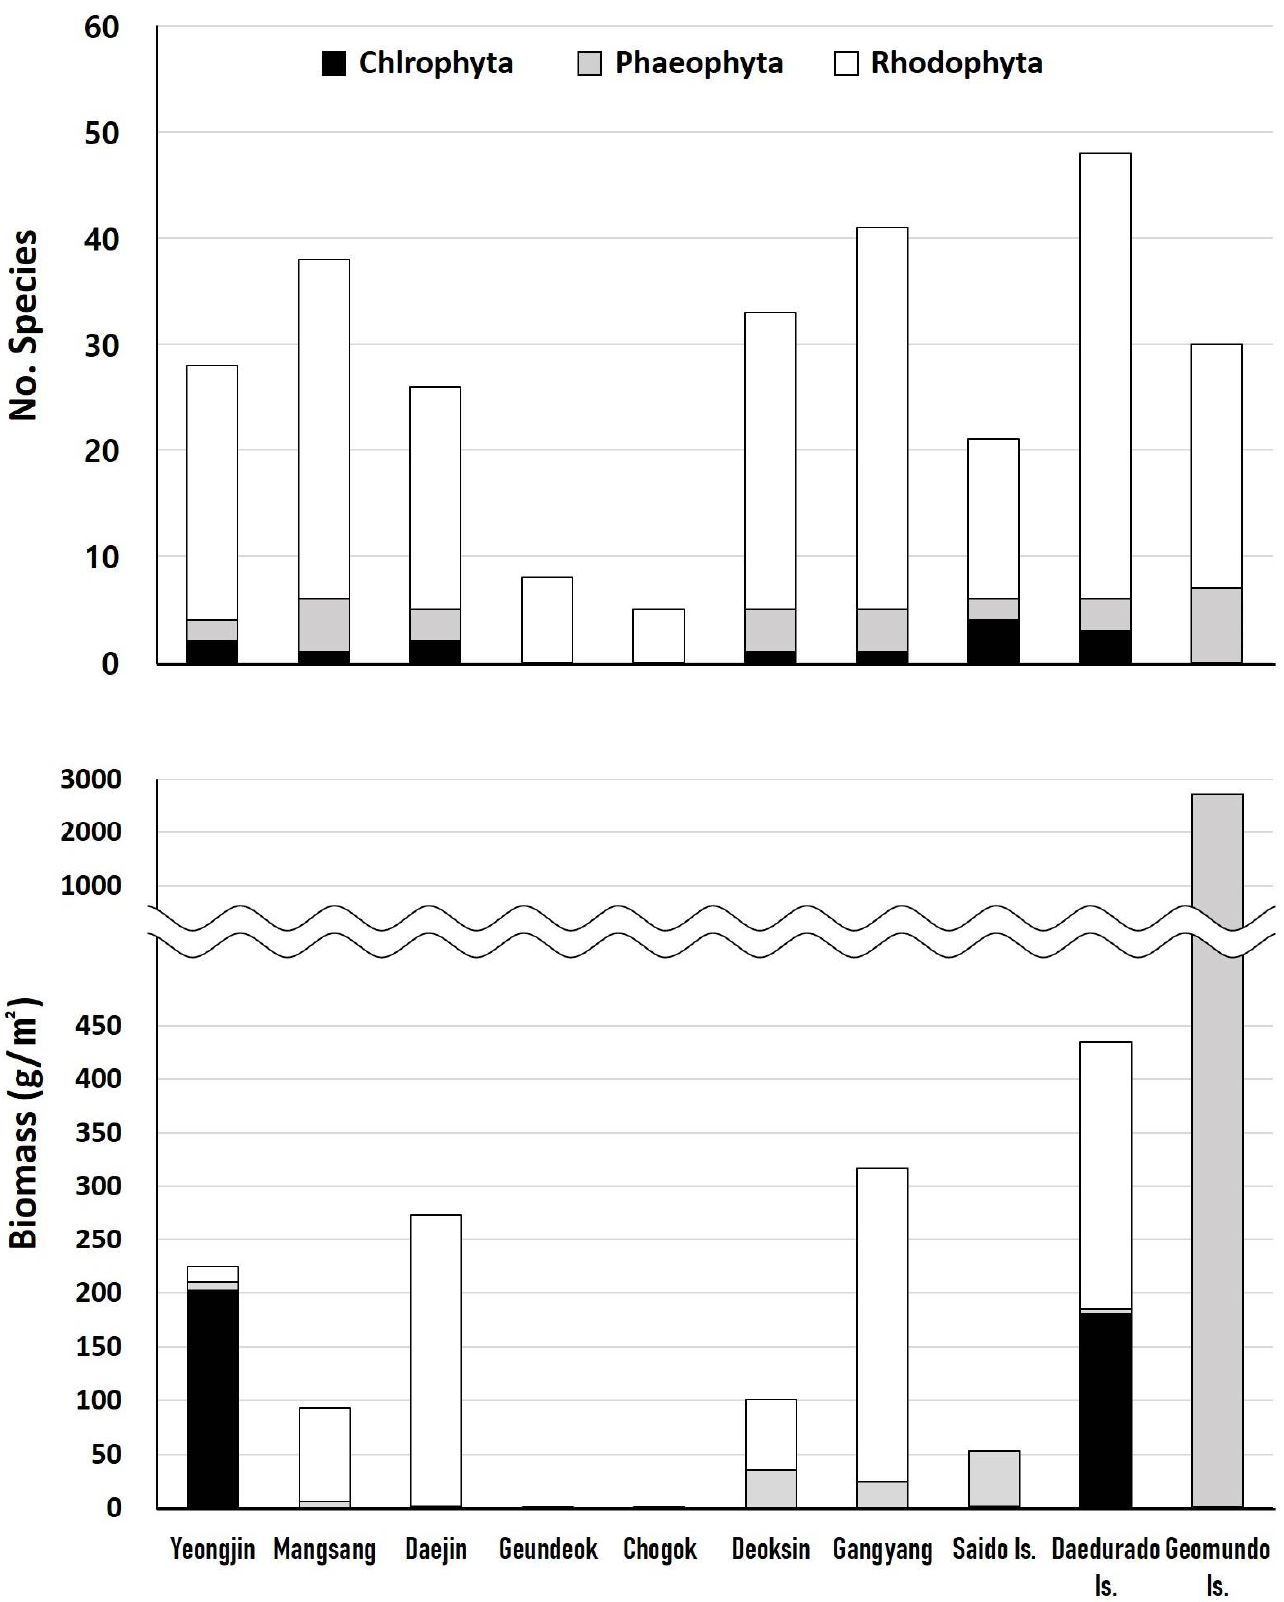
Figure 3. Species composition and biomass of seaweed beds at the study sites.